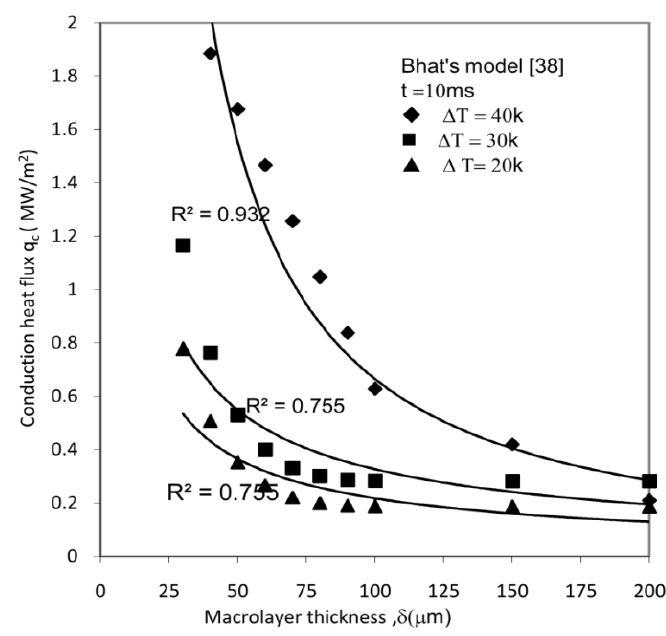
Figure 3. Effect of the macrolayer thickness on the heat flux for different superheats.